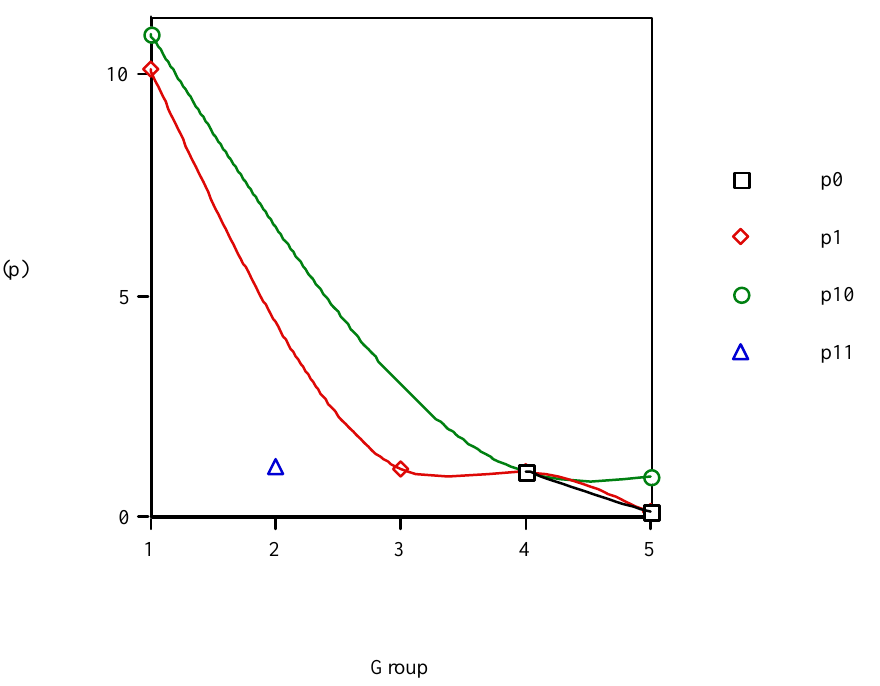
Figure 12. Variation of R ( p ) = P ( p +1)/ P ( p ) vs . group number. P is the vector